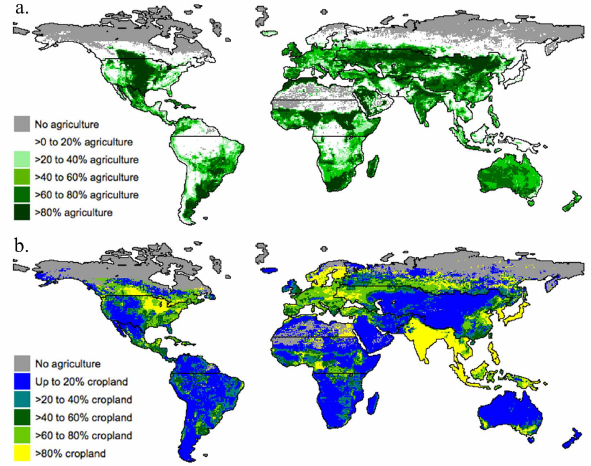
Fig. 4. Mean annual (2000–2009) land-use distributions from the HYDE 3.1 data set shown as (a) agricultural fraction of land area and (b) the composition of agricultural land as cropland versus pas-